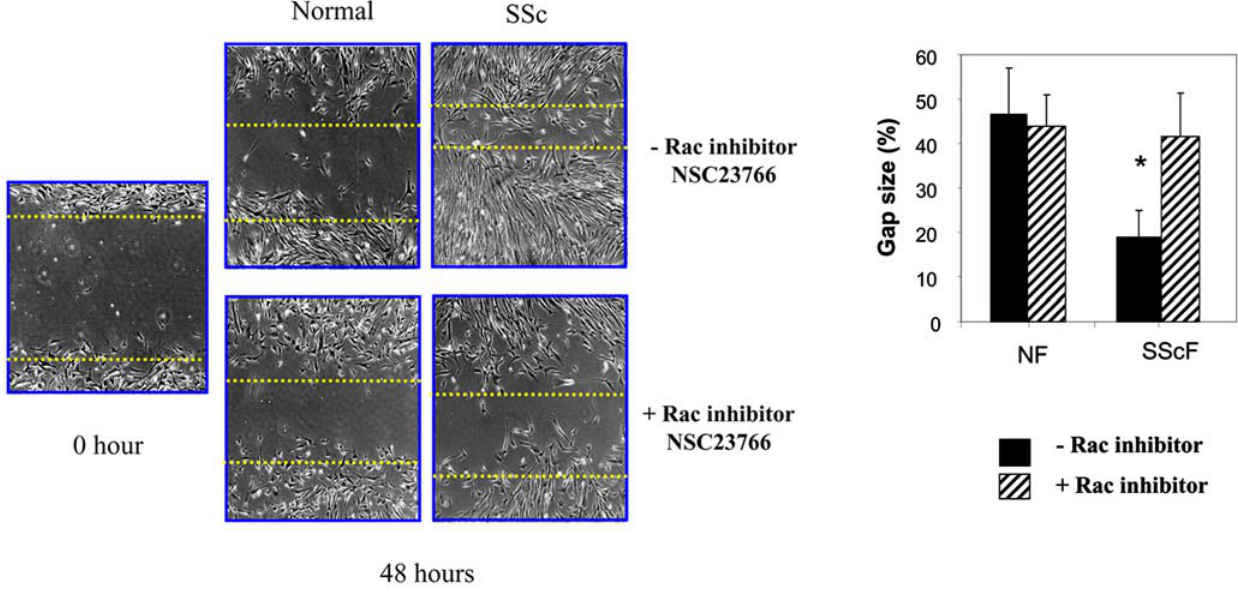
Figure 4 Rac inhibition reduces the enhanced migration of lesional SSc fibroblasts. Fibroblasts were subjected to a scratch wound assay in the presence or absence of 50 m M NSC23766. Cells were cultured on fibronectin until reaching confluence. A uniform linear scrape wound was made across the cell layer. Three independent experiments were performed Gap size expressed as a percentage of the original wound is shown (average + / 2 standard deviation) (*=p , 0.05 statistically different relative to untreated healthy